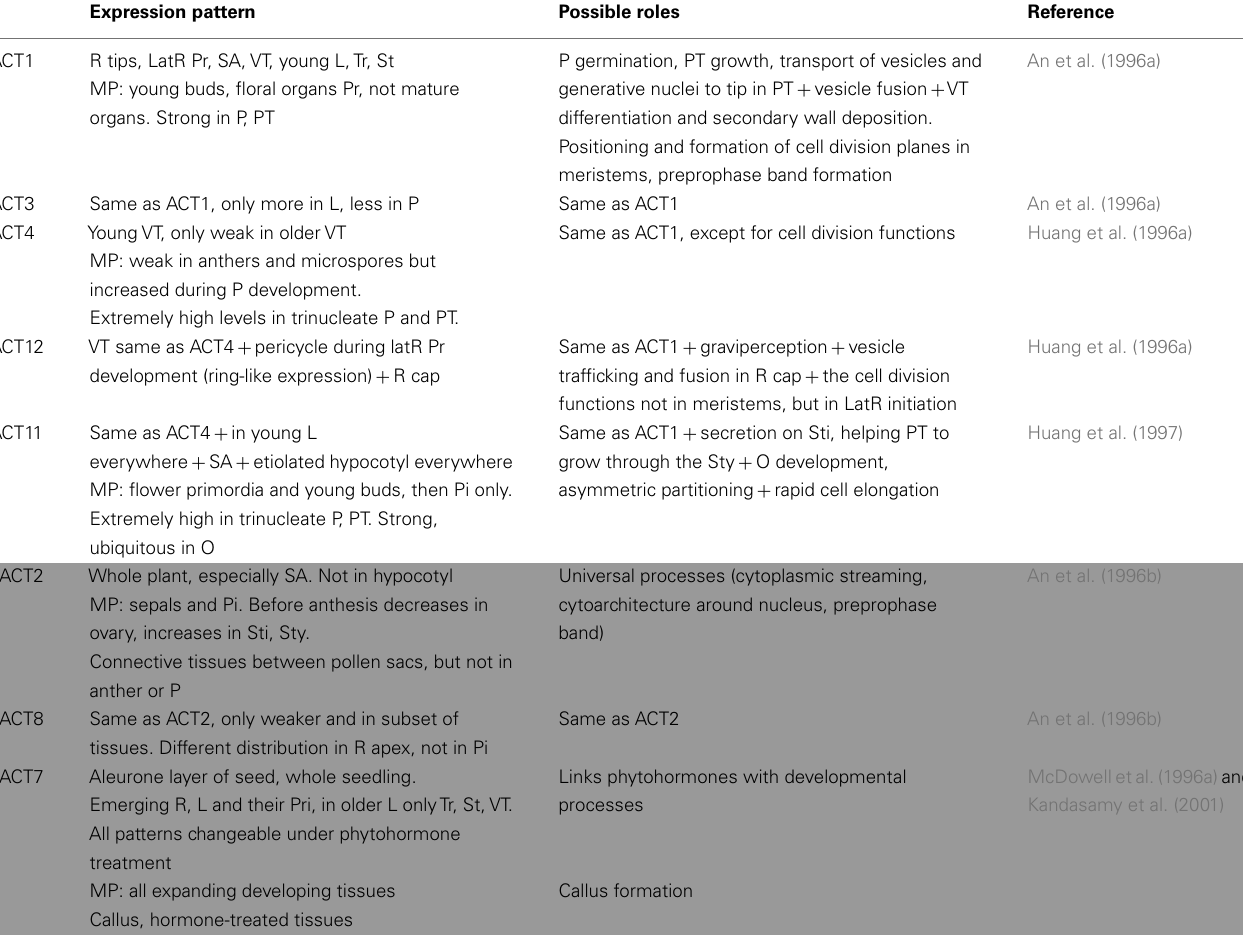
Table 2 | Expression patterns of actin isotypes and their possible